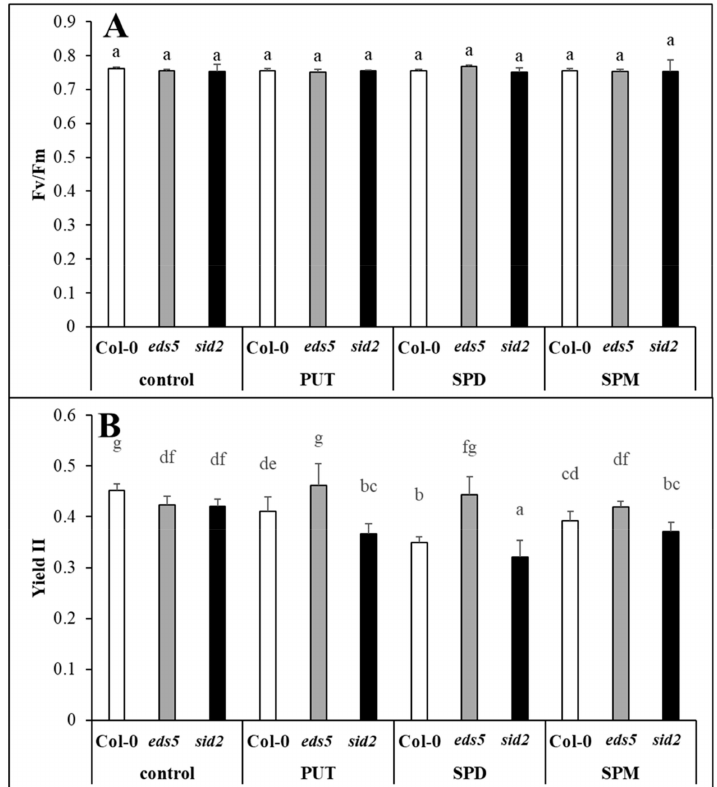
Figure 1. E ff ect of 0.5 mM 1-day of putrescine (PUT), spermidine (SPD) and spermine (SPM) treatments on the chlorophyll- a fluorescence induction parameters (( A ) Fv / Fm: maximum quantum yield of PSII photochemistry, ( B ) YII: E ff ective PSII quantum yield) in Col-0, wild type, eds5-1 ( eds5 ) and sid2-2 ( sid2 ) Arabidopsis mutants. Data represent mean values ± SD. Di ff erent letters indicate significant di ff erences at p ≤ 0.05